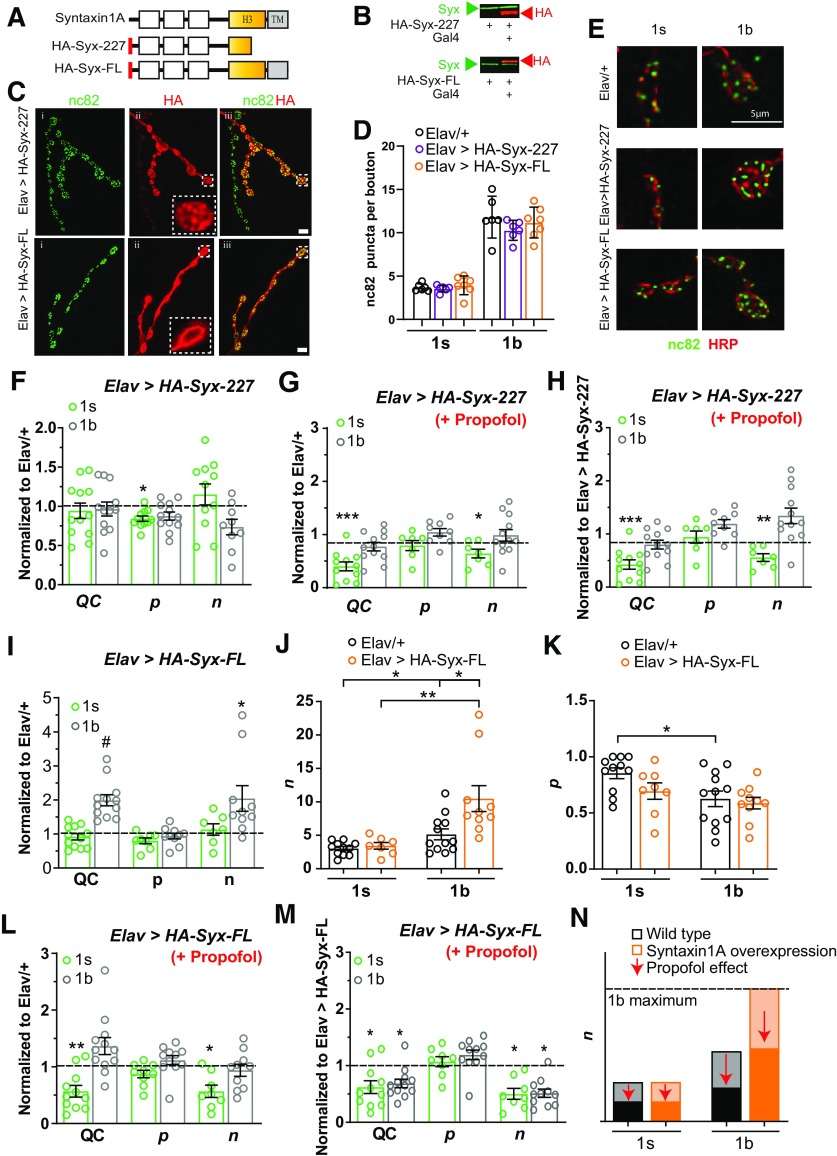
Syntaxin1A manipulations confer resistance to propofol by preserving or increasing the number of active release sites. A, Schematic representing the wild-type syntaxin1A protein, an HA-tagged truncated syntaxin1A construct (HA-Syx-227), and an HA-tagged full-length syntaxin1A construct (HA-Syx-FL). H3, SNARE interaction domain; TM, transmembrane domain. B, Coexpression of the truncated and full-length constructs in Drosophila shown by Western blot: endogenous wild-type syntaxin1A (green), HA-Syx-227, and HA-Syx-FL (red). C, Immunolabeling of larval boutons in HA-Syx-227 and HA-Syx-FL: left column, synaptic marker, nc82 (green); middle column, HA-labeling of coexpressed syntaxin1A (red, magnification of a single bouton is inset, showing localization of the coexpressed truncated syntaxin1A protein); right column, merge of nc82 and HA labels. Scale bar, 4 μm. D, Average number of active zones (±SEM) in Elav > HA-Syx-227 (N = 6) and Elav > HA-Syx-FL animals (N = 7) compared with Elav/+ controls (N = 6), for 1s and 1b boutons. E, Example boutons (labeled with HRP) and puncta (labeled with nc82) for the same strains as in D. F, QC, p and n for the two bouton types in Elav > HA-Syx-227, normalized to Elav/+ (dashed line; Extended Data Fig. 4-1). G, QC, p and n for the two bouton types in Elav > HA-Syx-227 + propofol, normalized to Elav/+ (dashed line; Extended Data Fig. 4-2). H, QC, p and n for the two bouton types in Elav > HA-Syx-227 + propofol, normalized to HA-Syx-227 without propofol (dashed line; Extended Data Fig. 4-3). I, QC, p and n (±SEM) for the two bouton types in Elav > HA-Syx-FL, normalized to Elav/+ (dashed line; Extended Data Fig. 4-4). J, Average number (±SEM) of estimated active release sites (n) in Elav > HA-Syx-FL animals, for 1b and 1s boutons. K, Average estimated release probability (p ± SEM) in Elav > HA-Syx-FL animals, for 1b and 1s boutons. L, QC, p and n (± SEM) for the two bouton types in Elav > HA-Syx-FL + propofol, normalized to Elav/+ (dashed line; Extended Data Fig. 4-5). M, QC, p and n (± SEM) for the two bouton types in Elav > HA-Syx-FL + propofol, normalized to HA-Syx-FL without propofol (dashed line; Extended Data Fig. 4-6). Individual data points in F–M are animals. *p < 0.05; **p < 0.01; ***p < 0.001, #p < 0.0001, Student’s t test. N, Summary schema of the opposing effects of syntaxin1A overexpression and propofol on the number of active release sites (n). Physiologic maxima for 1b boutons is indicated. Darker shading below arrows represents the proportional decrease in n, under propofol exposure.